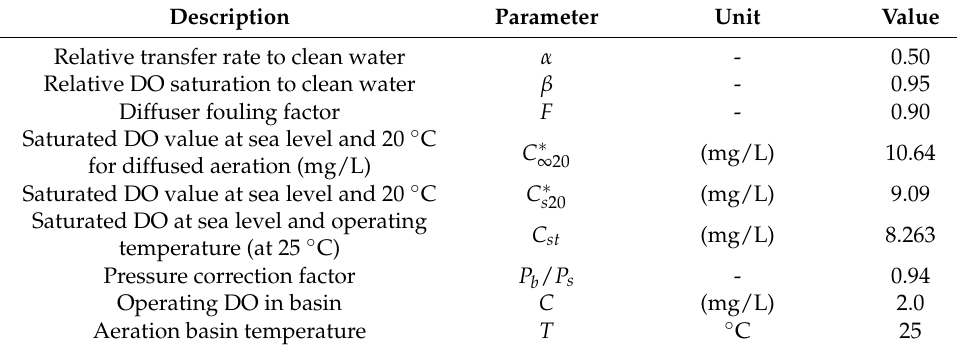
Table 2. Aeration process assumptions